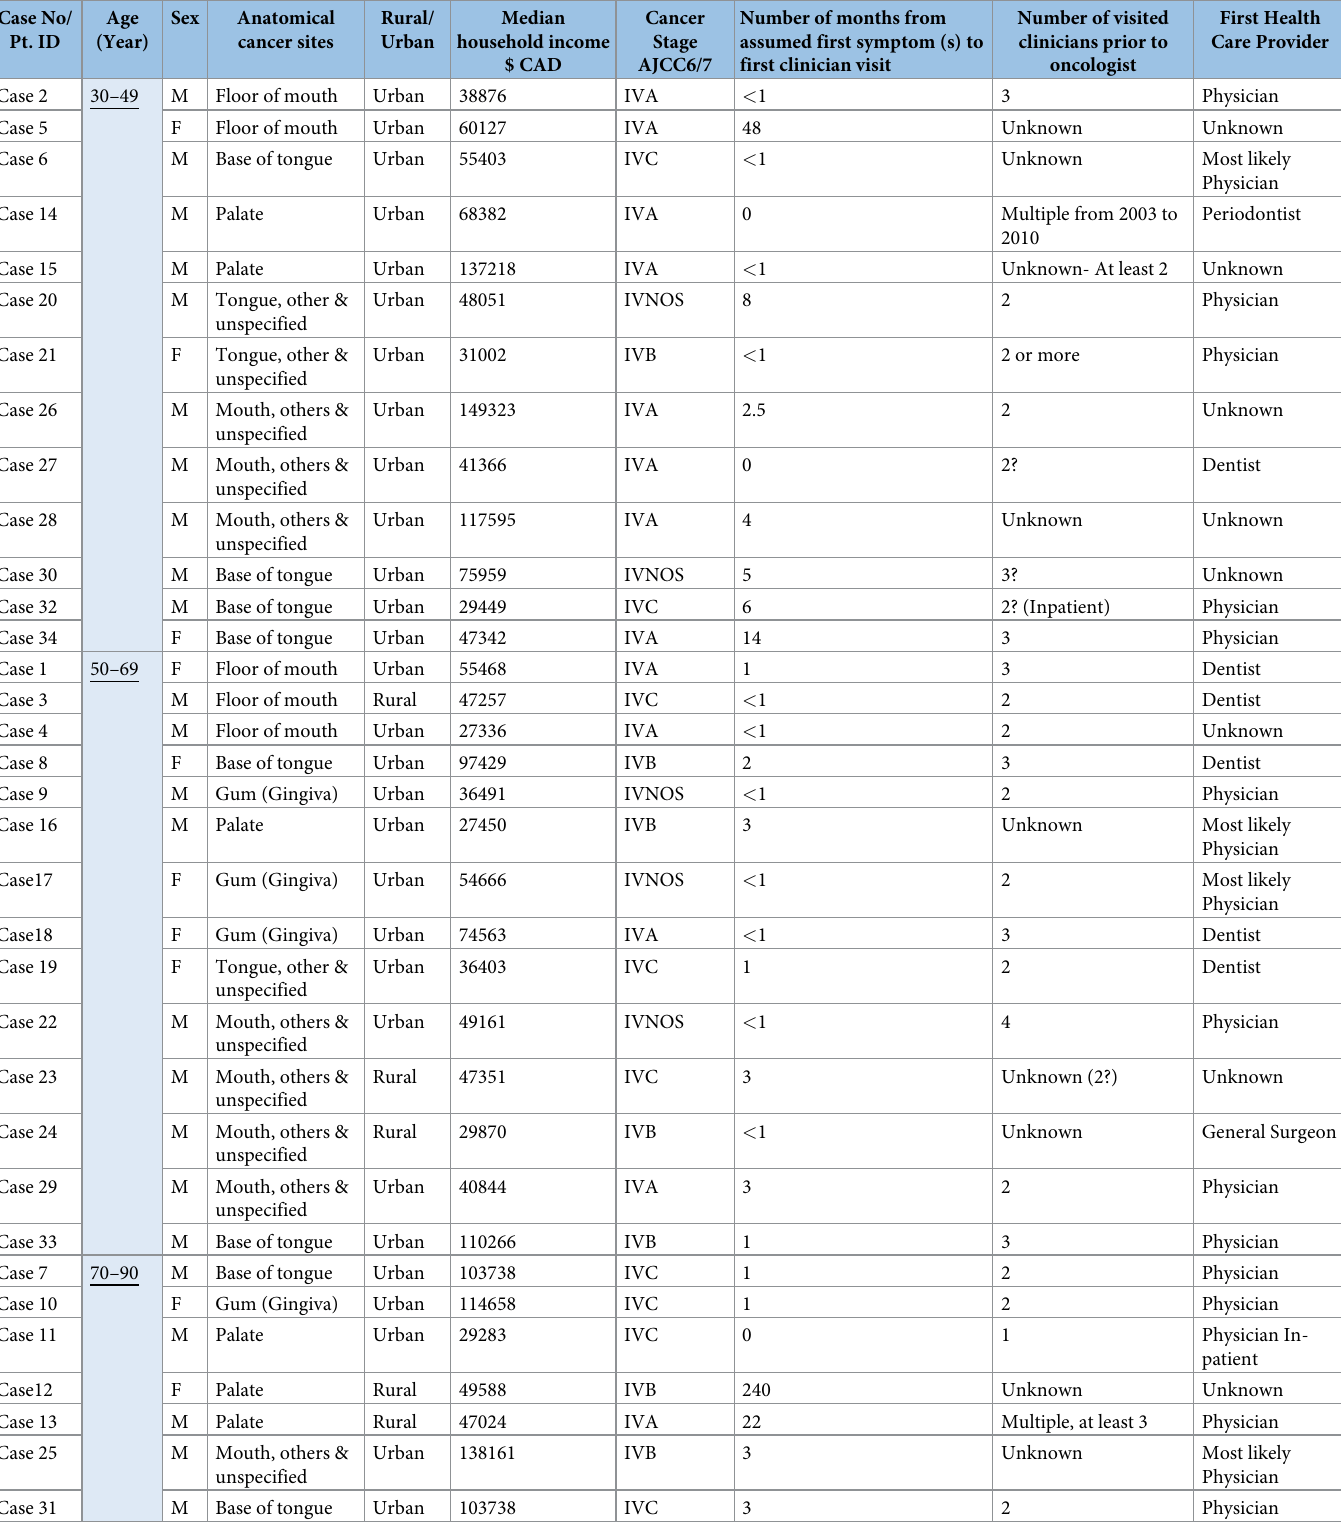
Table 2. Descriptive